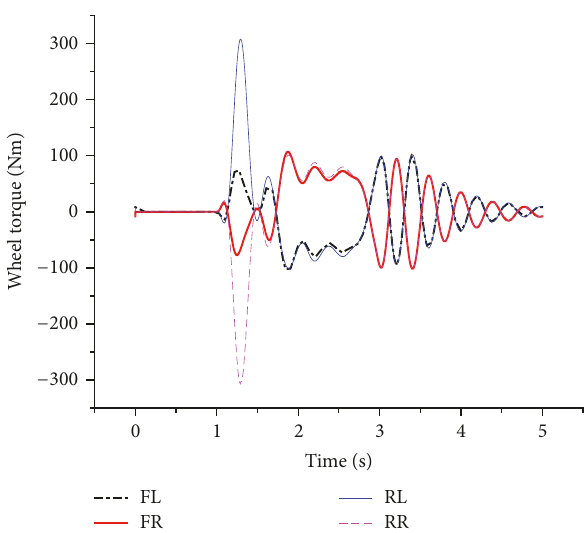
Figure 16: Four-wheel torque control input for in-wheel